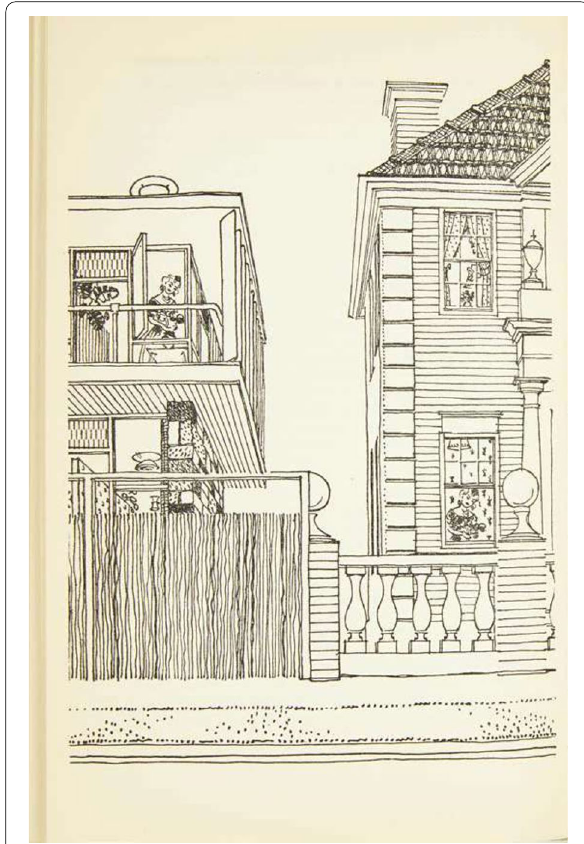
Fig. 2 Illustration from Boyd (1960, 174). Credits: Roy Simpson Collection, RMIT Design Archives. Illustration by Robin Boyd © Estate of Robin Boyd, courtesy Robin Boyd Foundation. https:// robin boyd. org.